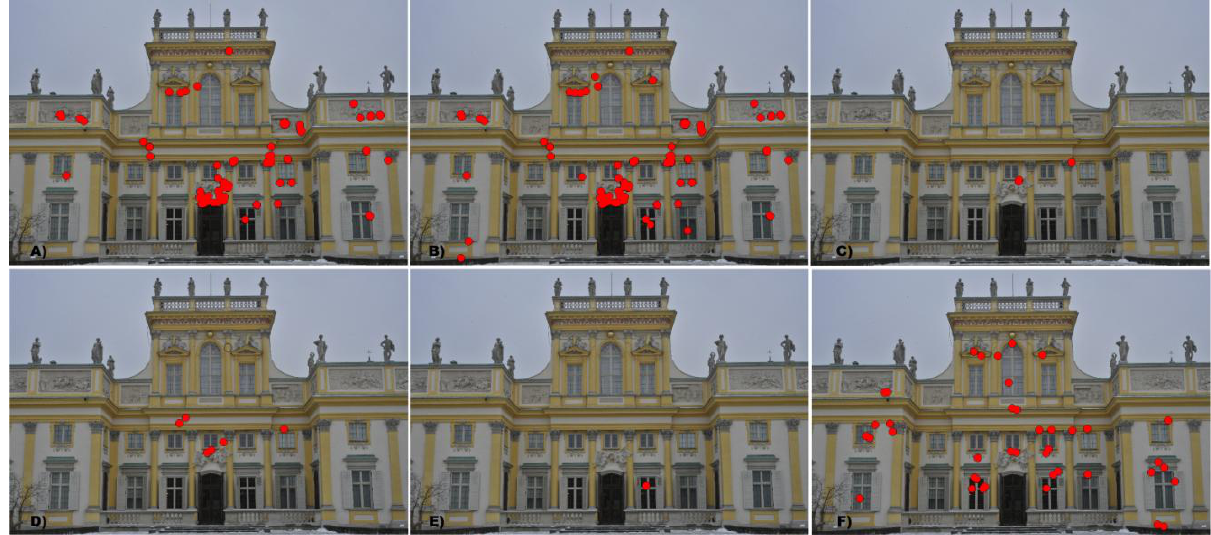
Figure 3. The distribution schema of points detected in the image and in the shaded DSM transformed into the image form for A) BRISK, B) FAST, C) STAR, D) MSER, E) SIFT and F) SURF detectors,